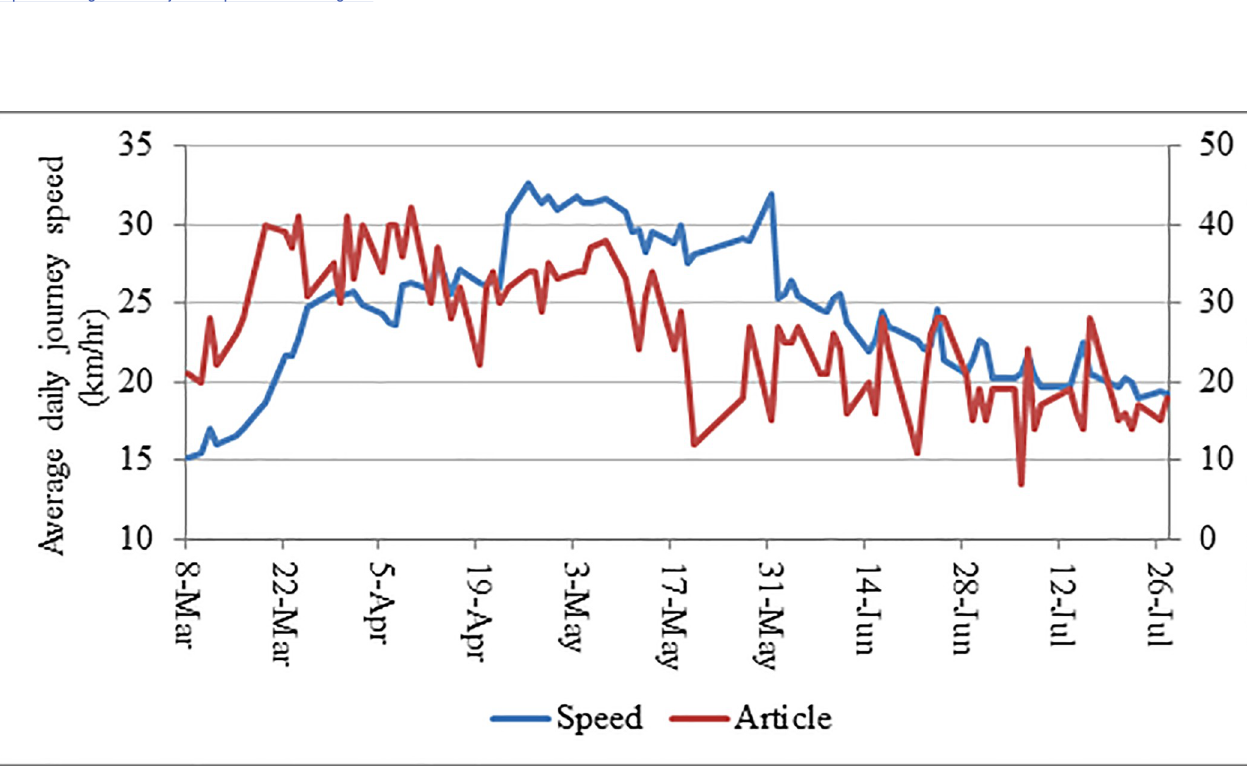
PLOS ONE | https://doi.org/10.1371/journal.pone.0252228 May 27,